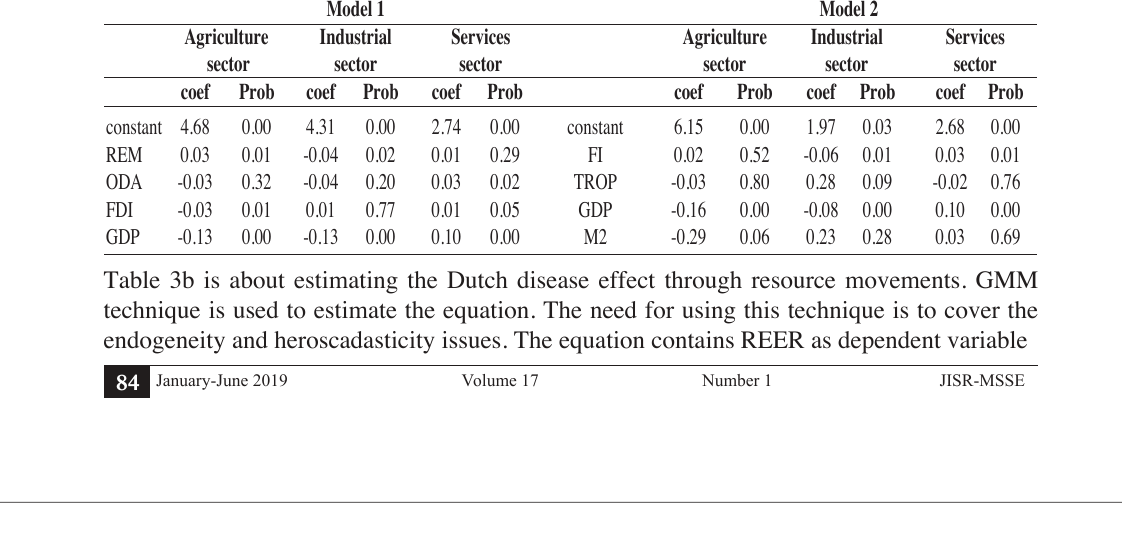
Table 3b: Dutch Disease through Resource Movement Effect Model 1